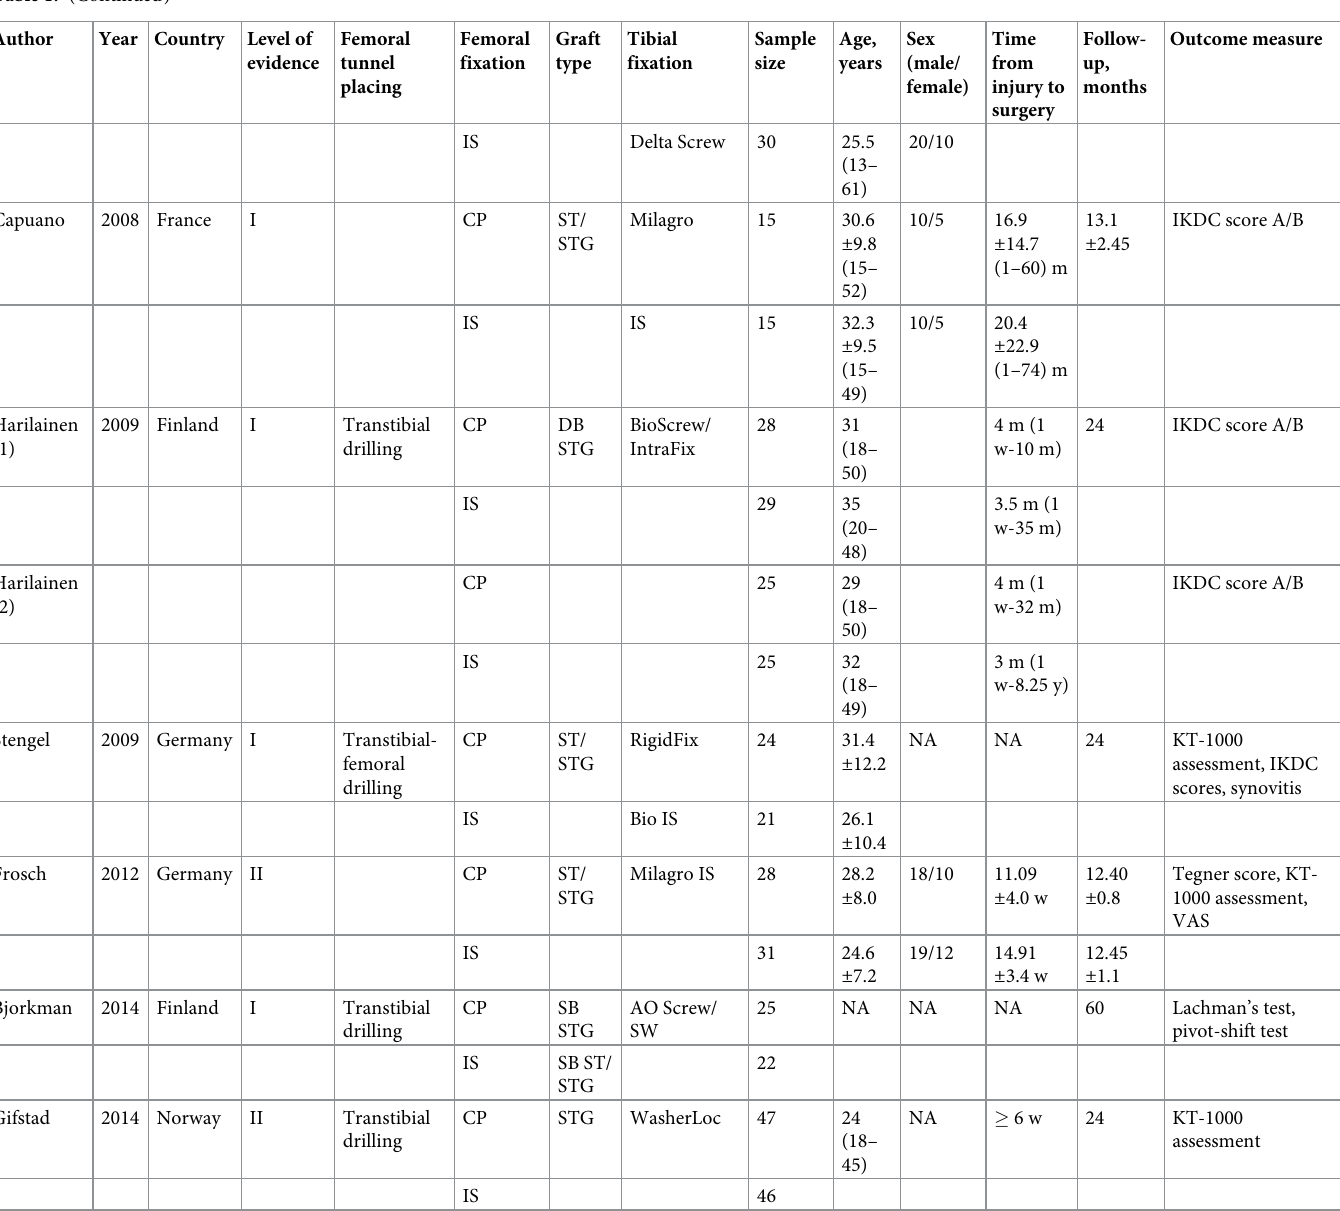
outcomes: IKDC score A or B (CP vs CB: pooled OR = 1.838, 95% CrI = 0.868–3.743; IS vs CB: pooled OR = 1.554, 95% CrI = 0.673–3.781; IS vs CP: pooled OR = 0.841, 95% CrI = 0.380– 2.102), Lachman’s test (CP vs CB: pooled OR = 1.511, 95% CrI = 0.523–4.406; IS vs CB: pooled OR = 1.153, 95% CrI = 0.324–4.092; IS vs CP: pooled OR = 0.758, 95% CrI = 0.284–2.104), pivot-shift test (CP vs CB: pooled OR = 1.254, 95% CrI = 0.577–3.203; IS vs CB: pooled OR = 0.564, 95% CrI = 0.253–1.582; IS vs CP: pooled OR = 0.456, 95% CrI = 0.159–1.357),